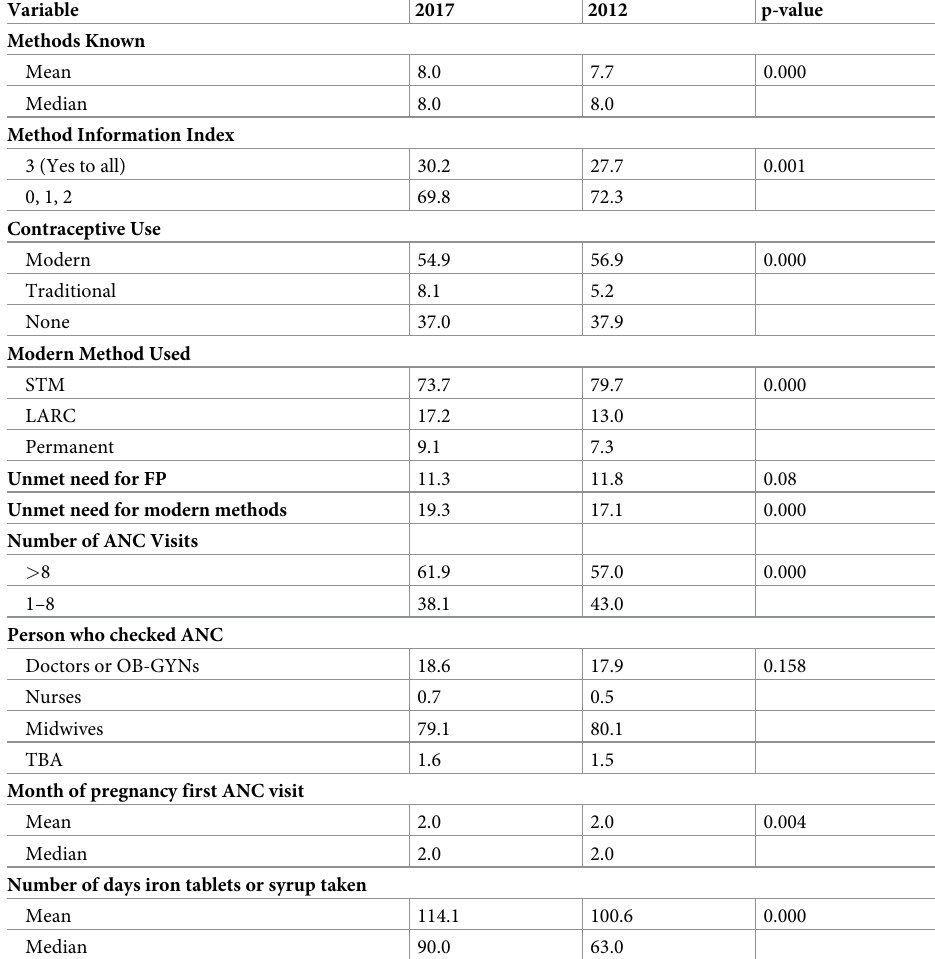
Table 2. Distributions of variables used in the analysis, married urban women, 2017 and 2012 IDHS a .